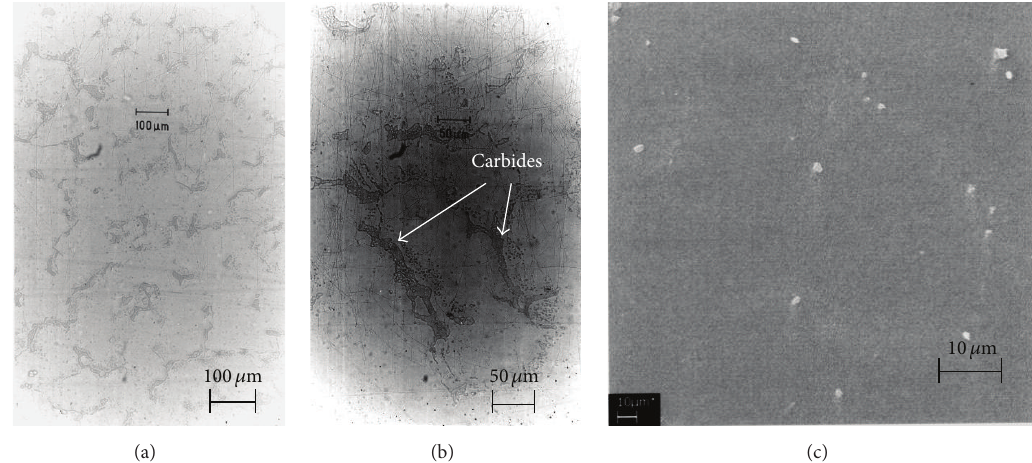
Figure 5: (a) General microstructure, (b) magnified microstructure of the low temperature zone (zone B), and (c) minor precipitation of carbide particles.